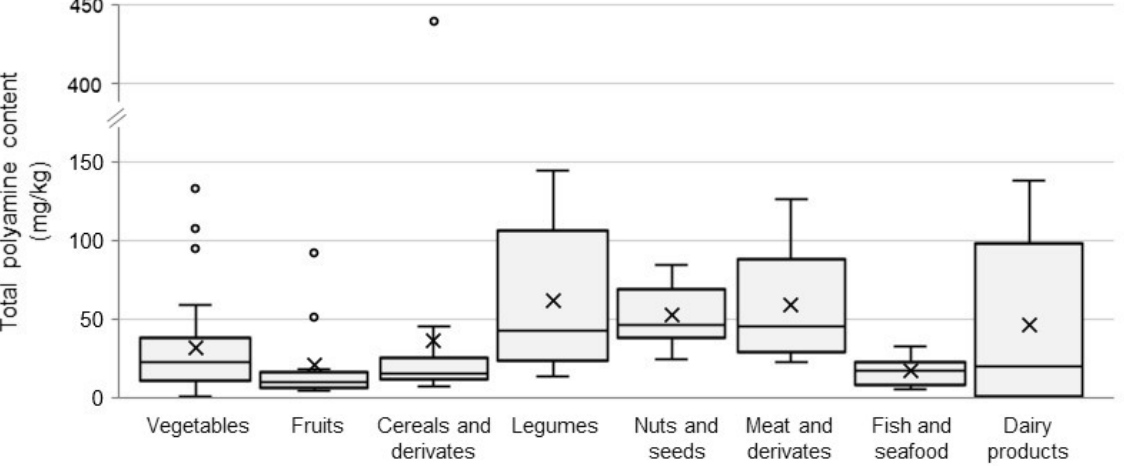
Figure 2. Distribution of the total polyamine content (mg/kg) by food category. The bottom and top of the box (interquartile range) are the percentile 25 and the percentile 75, respectively. The central line represents the median. Lines extending vertically from the boxes (whiskers) indicate variability outside the interquartile range. Outliers are plotted as circles.